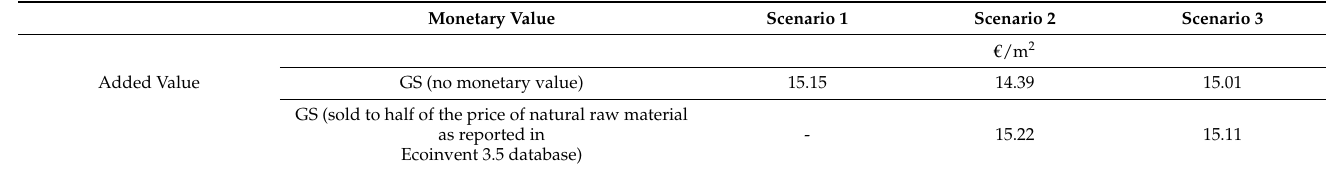
Table 7. Life-Cycle Added Value of Scenarios 1–3 calculated according to